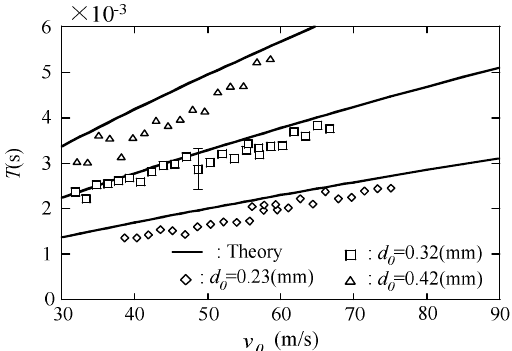
Fig. 11 The time necessary for bubble separation ( U